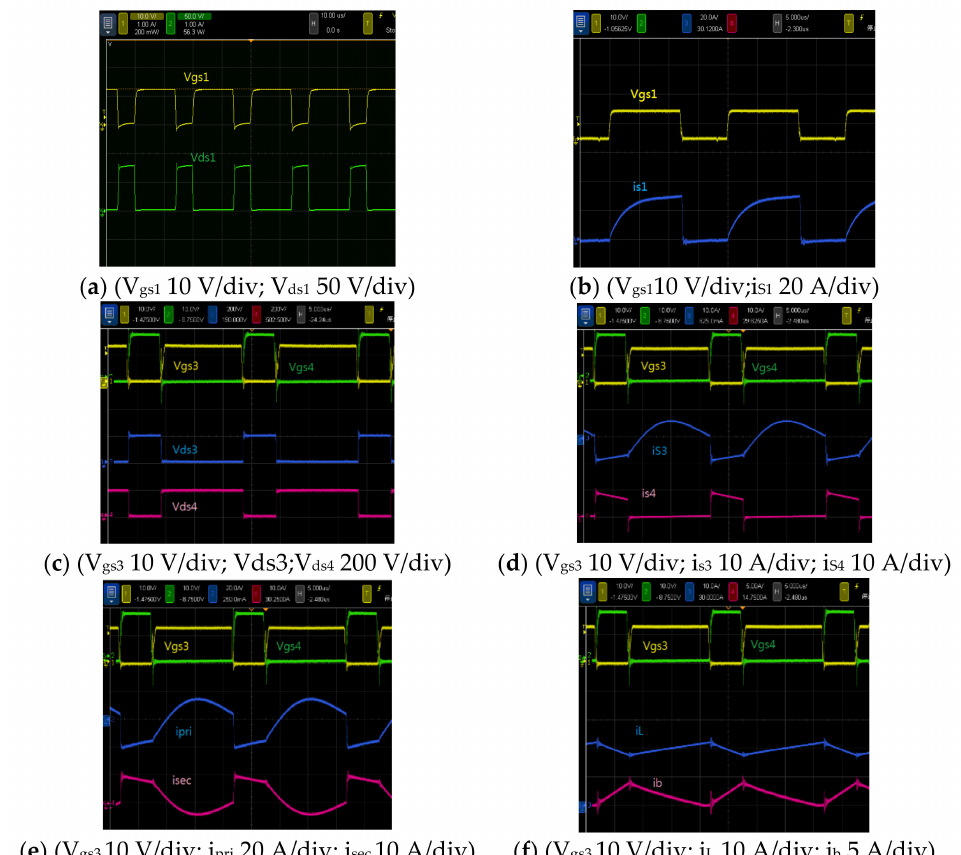
Figure 15. Measured results under Stage 1 at 500 W: ( a , b ) switch S 1 waveforms, ( c , d ) switches S 3 and S 4 waveforms, and ( e , f ) current waveforms of transformers and inductors,